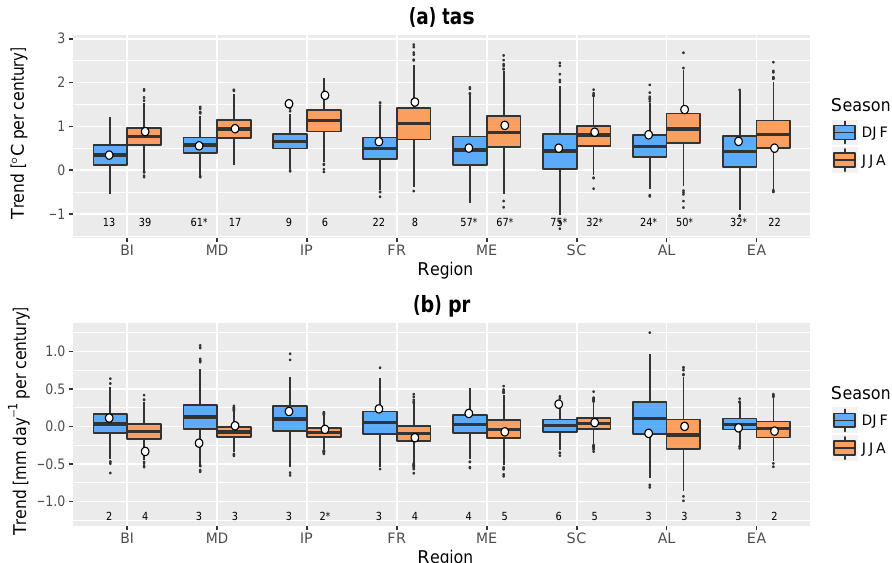
Figure 17. Regional summer and winter trends in (a) temperature and (b) precipitation. Boxes show the distribution of trend values using 1000 time series constructed by randomly sampling one w@h2 ensemble member per year, with outliers shown as black dots. White dots show the observed regional trend estimated from CRU-TS. Theil–Sen linear trend slopes are computed using regional averages and signif- icance is tested using a Mann–Kendall test. The numbers below the boxes indicate the percentage of w@h2 time series with a statistically significant trend (at the 5% level), and with an asterisk if the observed trend is